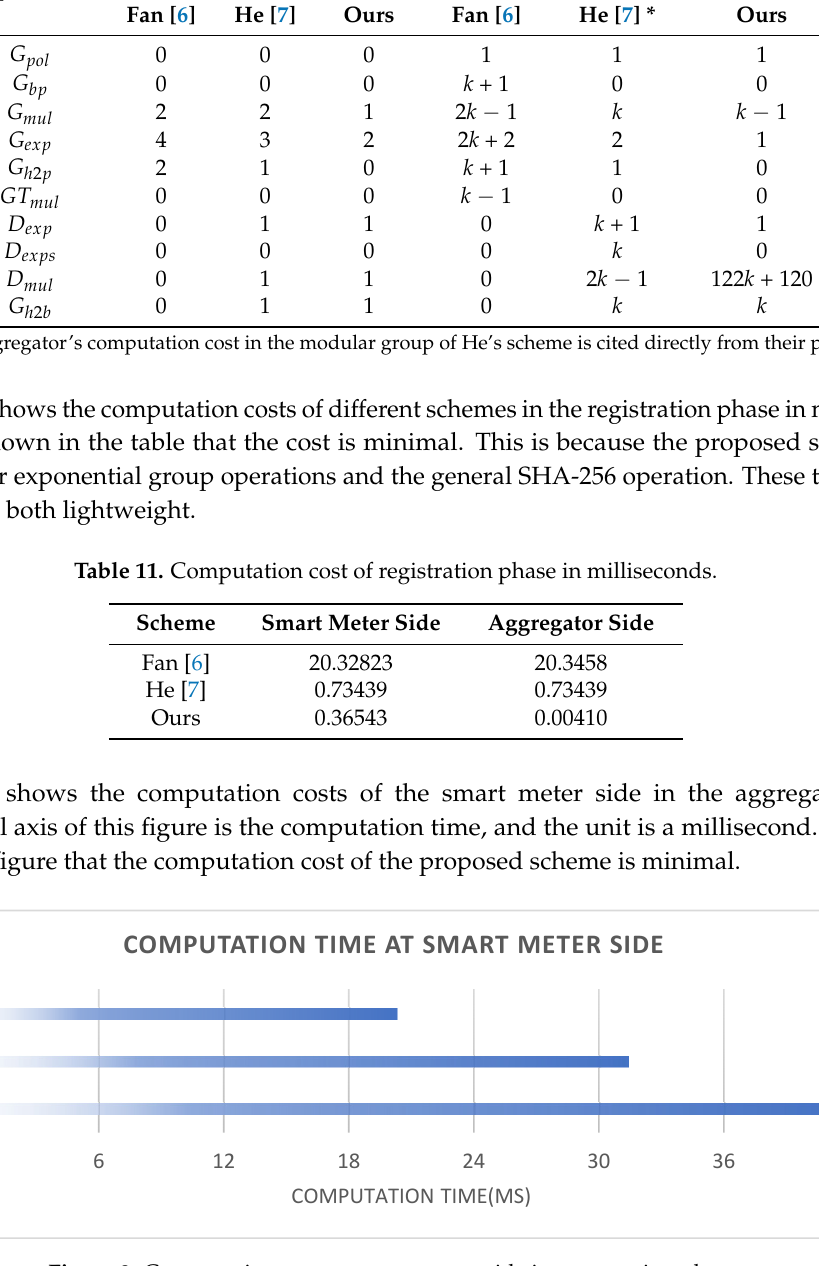
Table 10. Computation cost of aggregation phase.